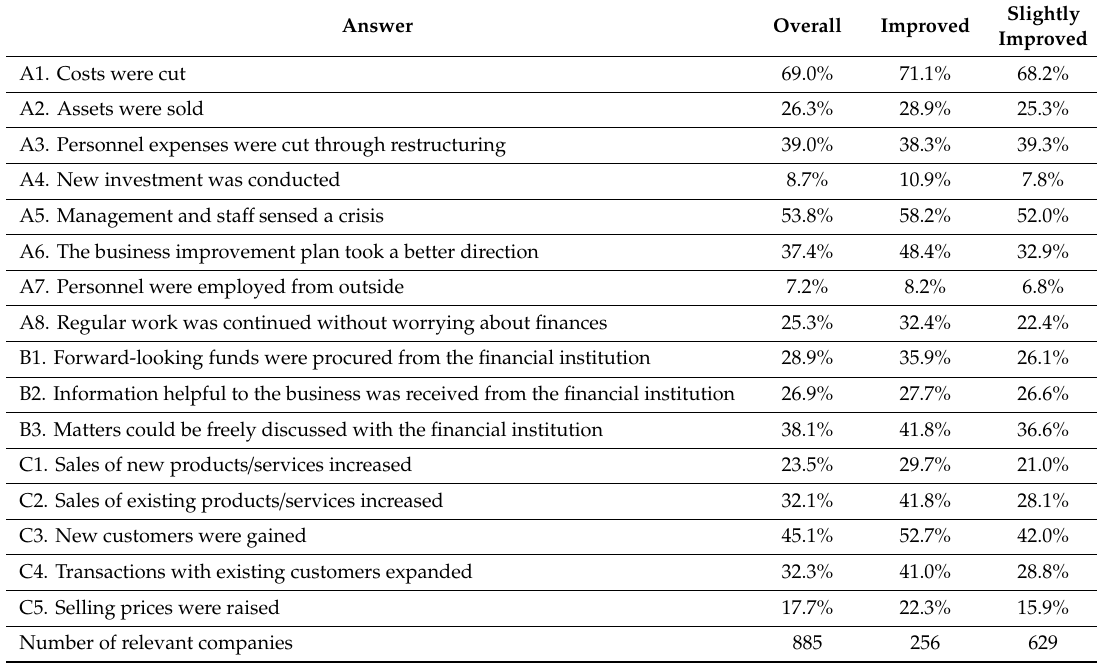
Table 12. Self-evaluation on the reasons for the improvement in companies with an improved trend. Answer